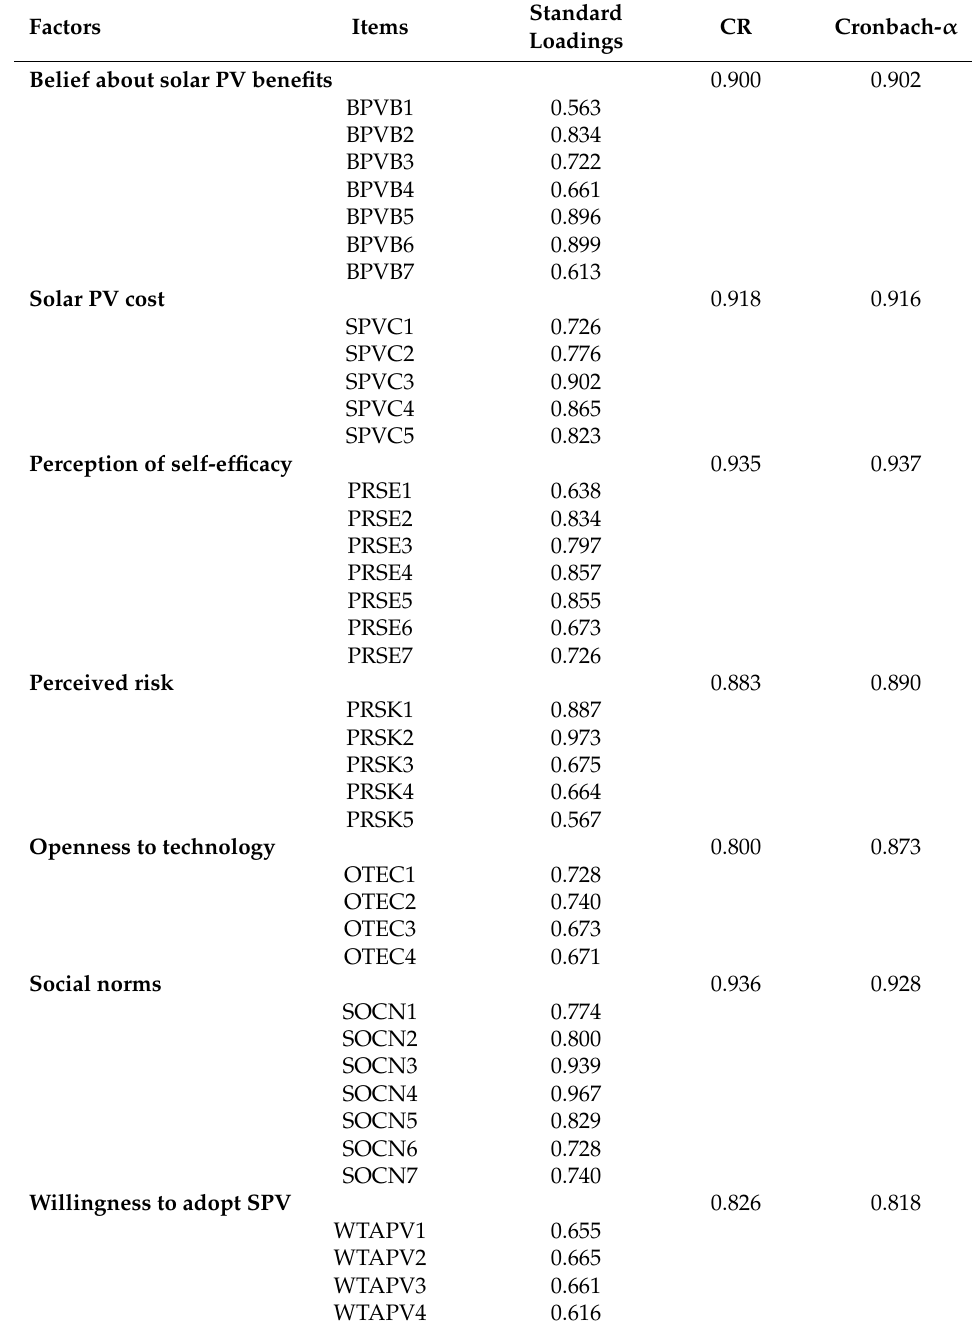
Table 7. Factor loadings and results of reliability analysis.